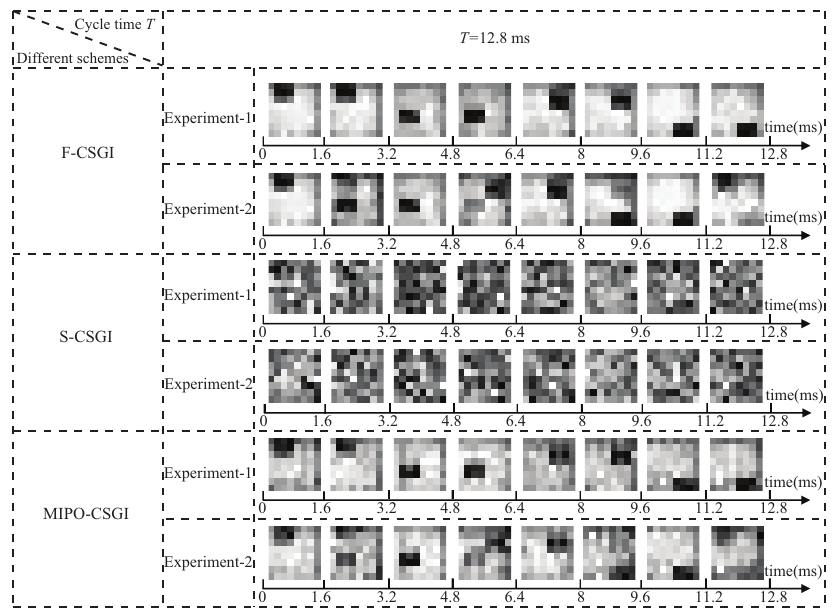
Figure 7. Experimental results of reconstructing eight frames of a jumping “square”using F-CSGI, S-CSGI, and